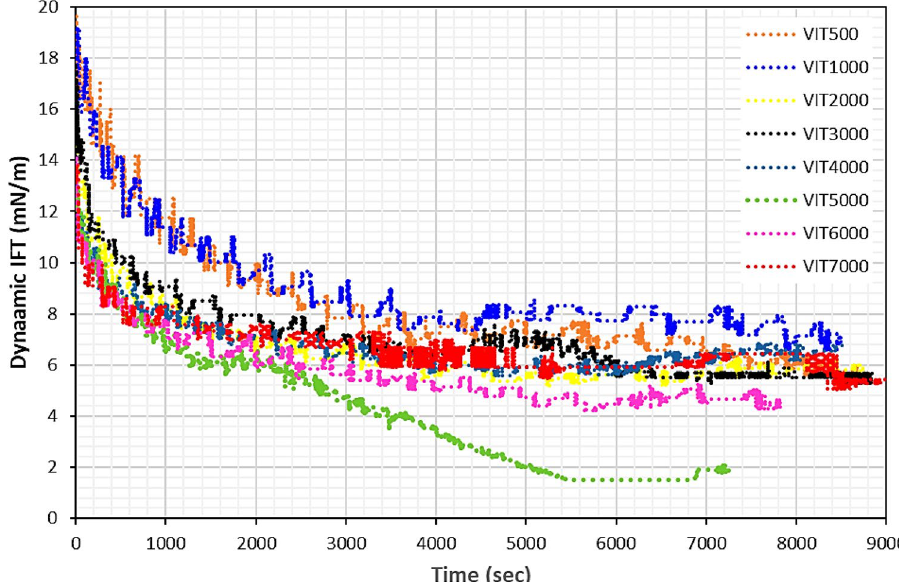
Fig. 12 Dynamic IFT profiles measured for different crude oil– Vitagnus surfactant solu- tion systems for the period of 150